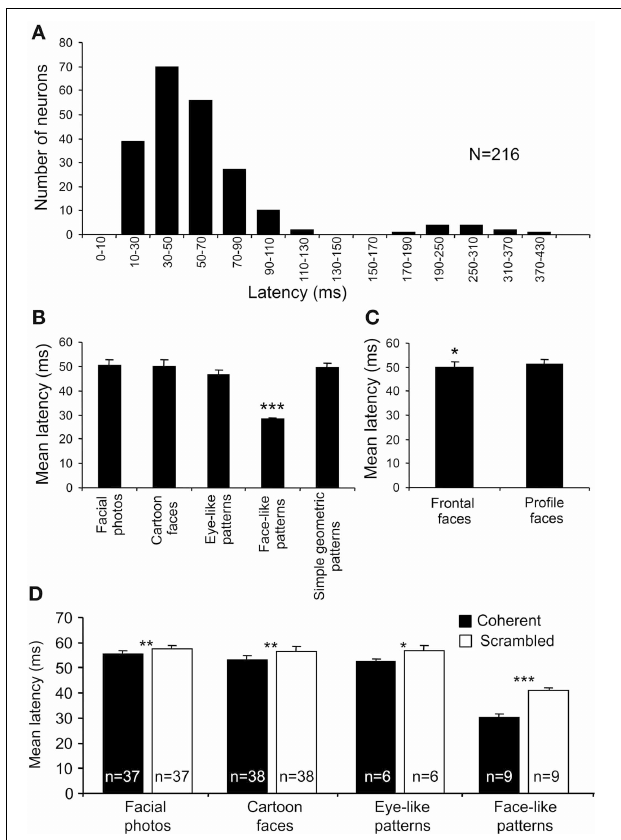
FIGURE 7 | Response latencies of the 216 visually responsive sSC neurons. (A) The distribution of the mean response latencies. The distribution of the latencies formed two peaks: a short-latency group (10–130ms) and a long-latency group (170–430ms). (B) Comparison of the response latencies among the stimulus categories in the short-latency group. The mean response latencies to the face-like patterns (J1–4) were significantly shorter than those to the other stimulus categories ( ∗∗∗ p < 0 . 001; Bonferroni tests after repeated measures One-Way ANOVA). (C) Comparison of the response latencies between the head orientations. The mean response latencies to the frontal faces were significantly shorter than those to the profile faces ( ∗ p < 0 . 05; paired t -test). (D) Effects of scrambling of the images on response latencies. Scrambling significantly increased the mean response latencies ( ∗ p < 0 . 05; ∗∗ p < 0 . 01; ∗∗∗ p < 0 . 001; paired t